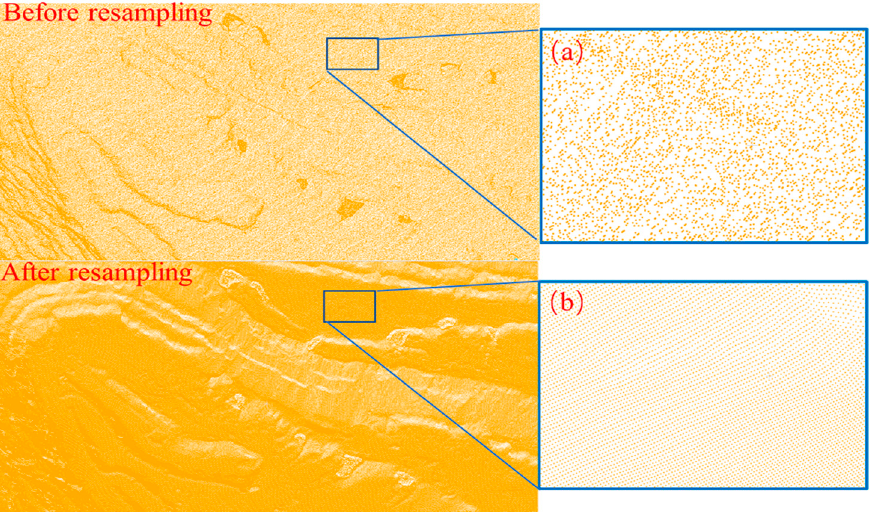
Figure 13. Comparison of MLS resampling results: ( a ) point-cloud details before resampling, ( b ) point-cloud details after resampling.